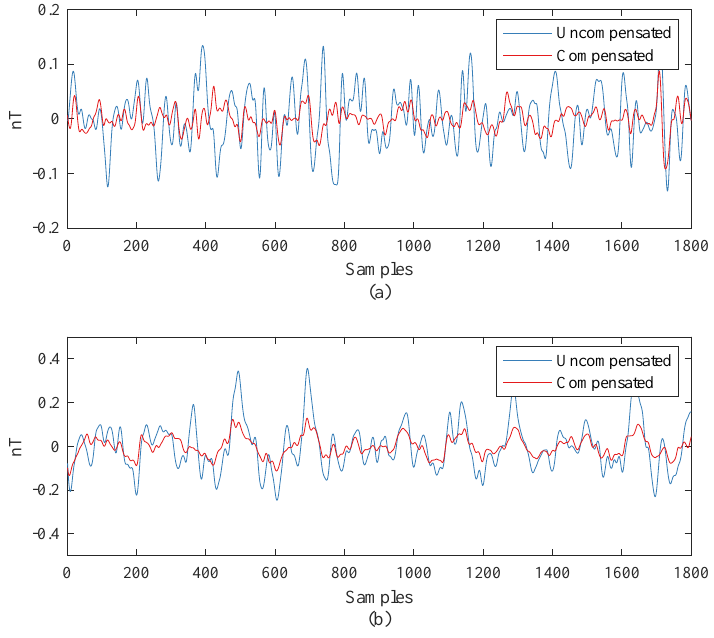
Figure 7. Compensation results: ( a ) Line-A and ( b ) Line-B. Table 6. The STDs and IRs of the three methods on Line-A and